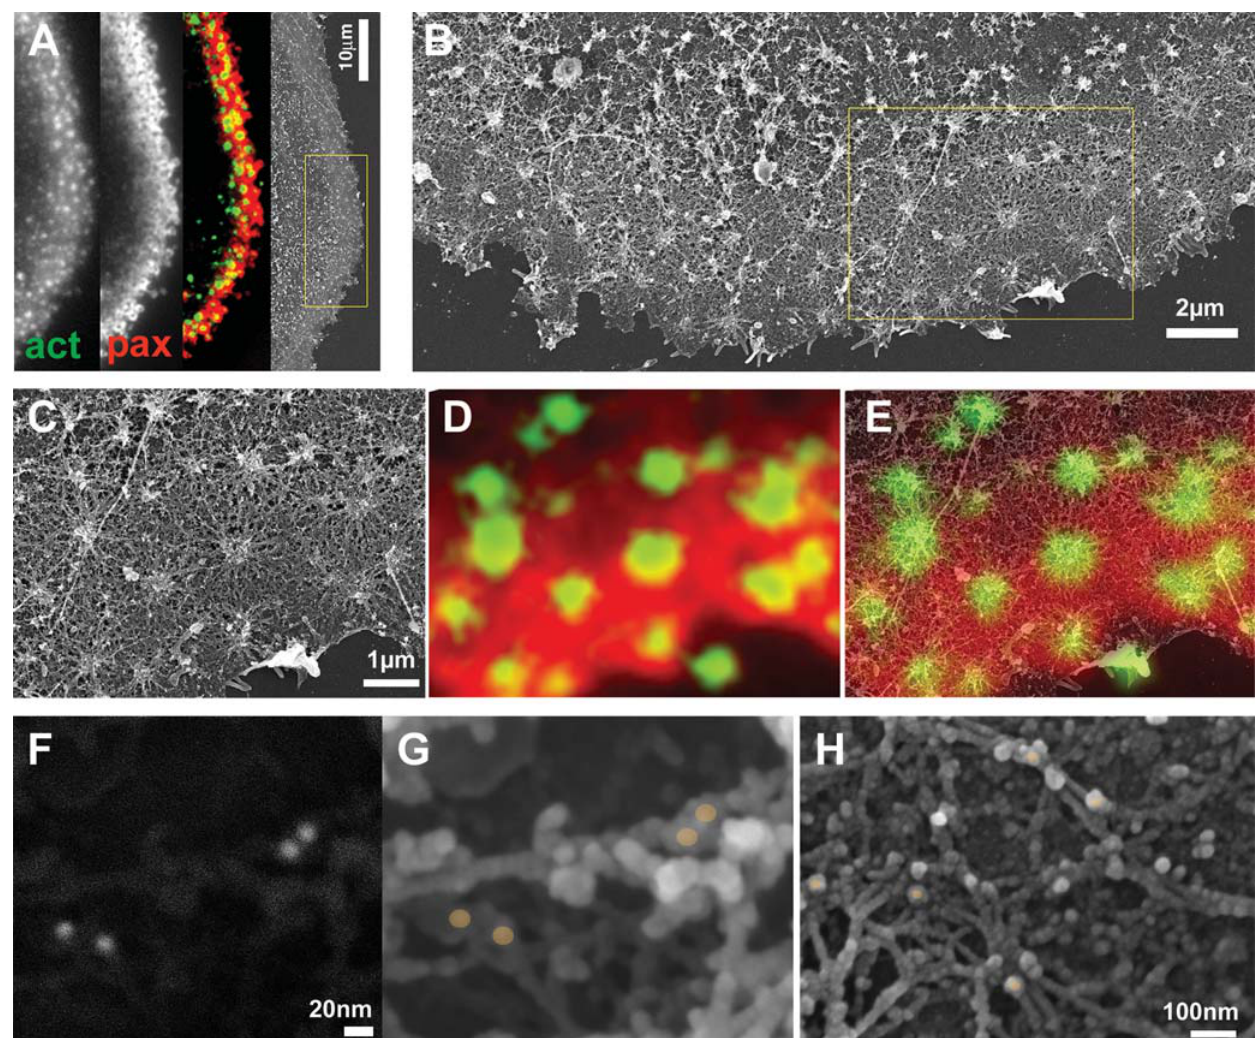
Figure 5. Structural relations between podosome ring and core domains. (A) Osteoclast ventral membranes were labeled for paxillin and actin, and simultaneously prepared for HR-SEM. On the left is the actin labeling, followed by paxillin labeling and by their merged picture. On the right is the corresponding SEM micrograph. (B) Higher magnification view of the area in the yellow rectangle in (A). (C) Higher magnification view of the area in the yellow rectangle in (B). (D) Merged actin/paxillin labeling from the same area as in (C). (E) Merged image between (C) and (D). The correlation between SEM and immunofluorescence shows paxillin association with podosome radial actin fibers, reaching up to but not co-localizing with the central bundle. (F, G, H) Osteoclast ventral membranes were labeled for paxillin with 15nm colloidal gold particles and visualized by back scattering signal (F) or secondary electron detector (G, H). (F) and (G) show the same area. The colloidal gold particles in (G, H) are marked with brownish dots, showing paxillin in association with actin fibers in close proximity with the ventral